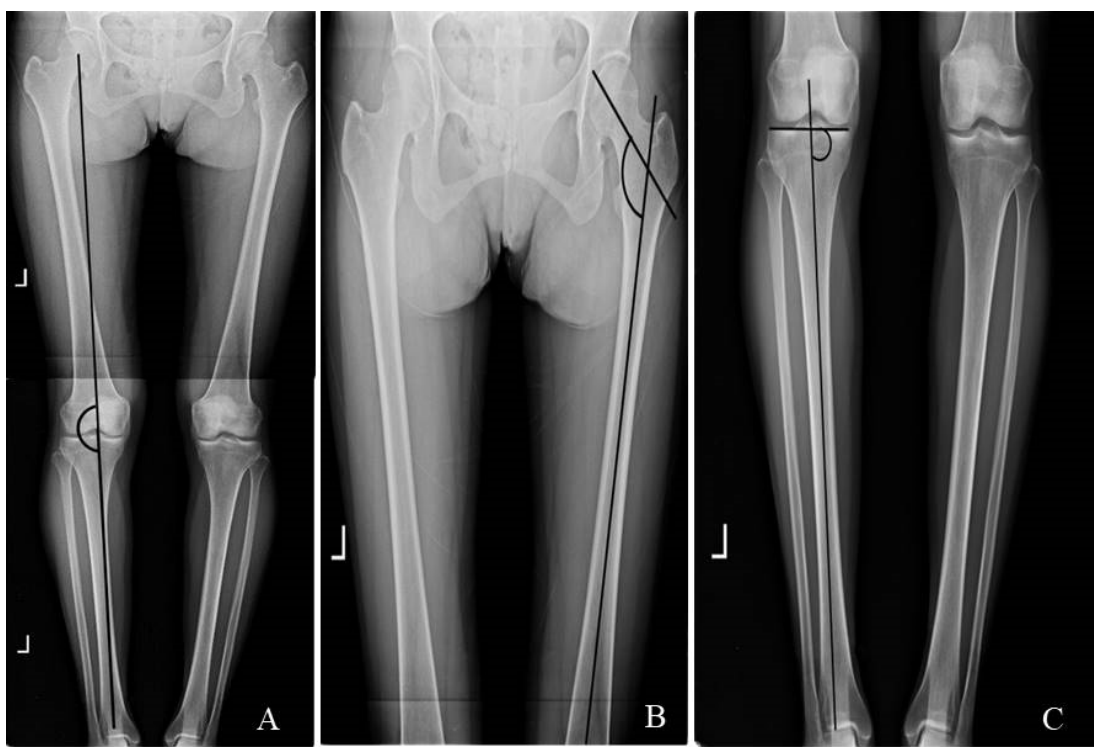
Figure 2. Measurement of lower extremity alignment: ( A ) measurement of hip–knee–ankle angle; ( B ) measurement of hip inclination angle; ( C ) measurement of medial proximal tibia angle.